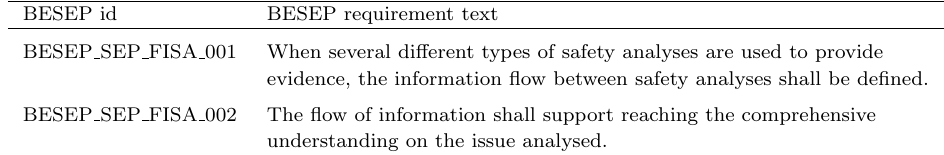
Table 1. BESEP requirements related to flow of information between safety analyses.